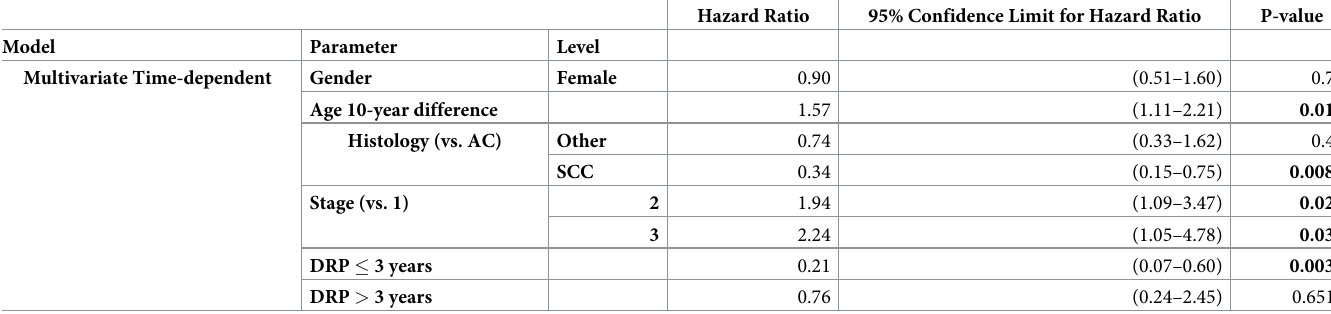
Table 3. Pooled cohorts, multivariate time-dependent model, endpoint disease-specific survival.